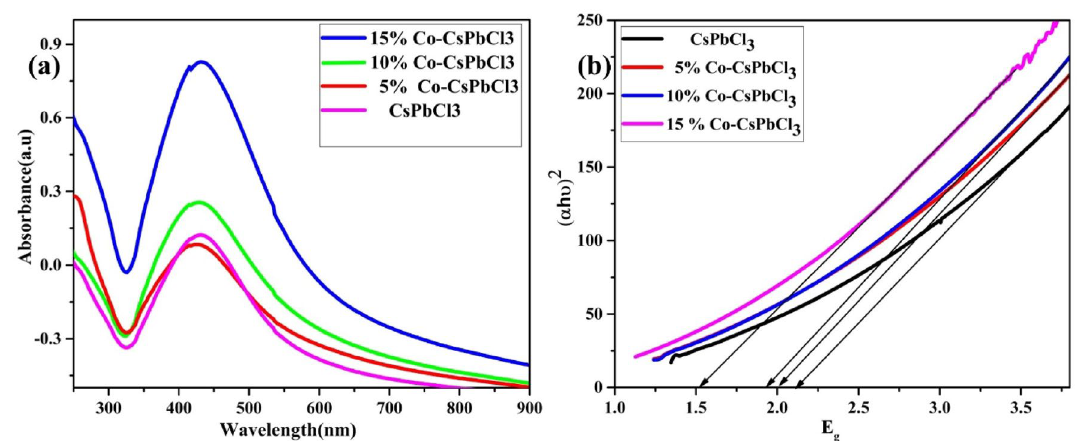
Figure 7. ( a ) Optical absorption onset and Tauc plot of CsPbCl 3 and ( b ) Co:CsPbCl 3